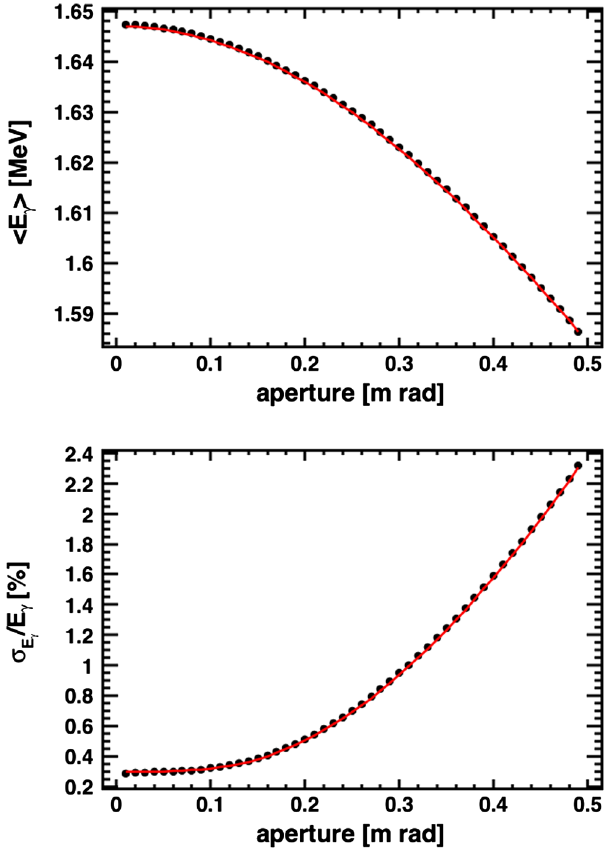
FIG. 1. Average energy (top) and relative bandwidth (bottom) of the photon beam estimated with CAIN (black dots) and using the analytical formula (red line) given in Eqs. (26) and (27) as a function of the angular aperture. The statistical uncertainty that the size of the dots. The two curves are superimposed within a few 10 − 4